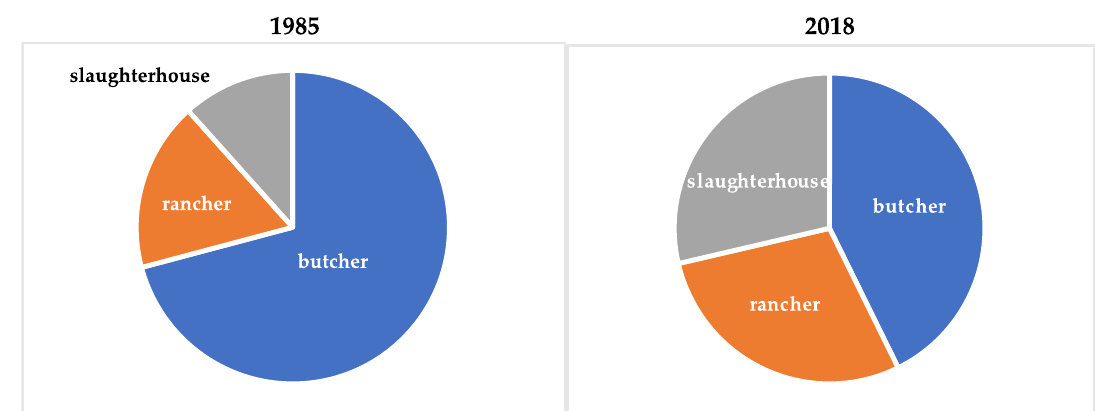
Figure 6. Destination of household Cattle.